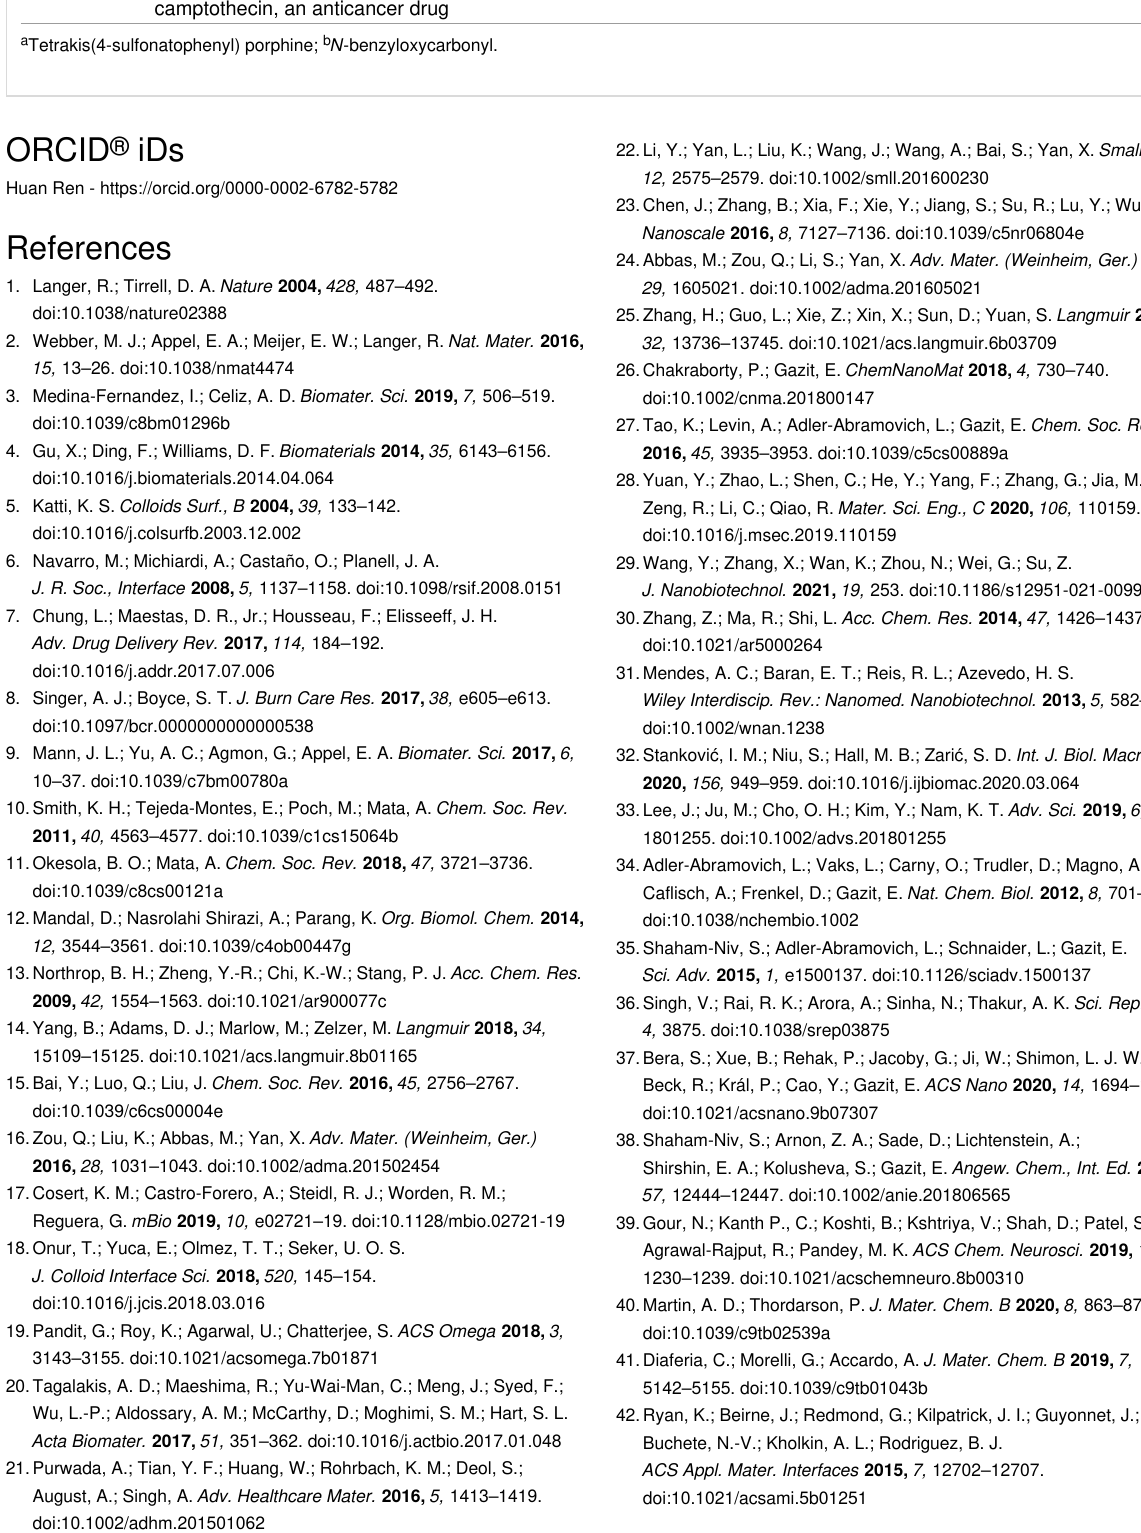
Table 1: Summary of amino acids/amino acid derivatives and their applications. (continued)